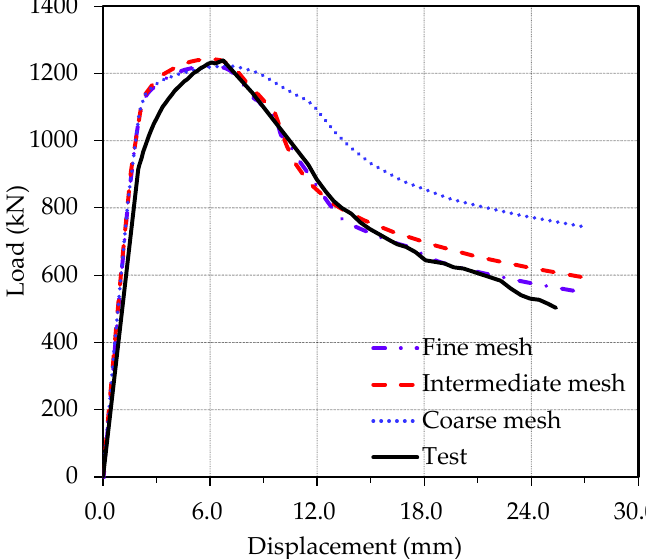
Figure 15. Effect of different mesh sizes on finite element simulation results.